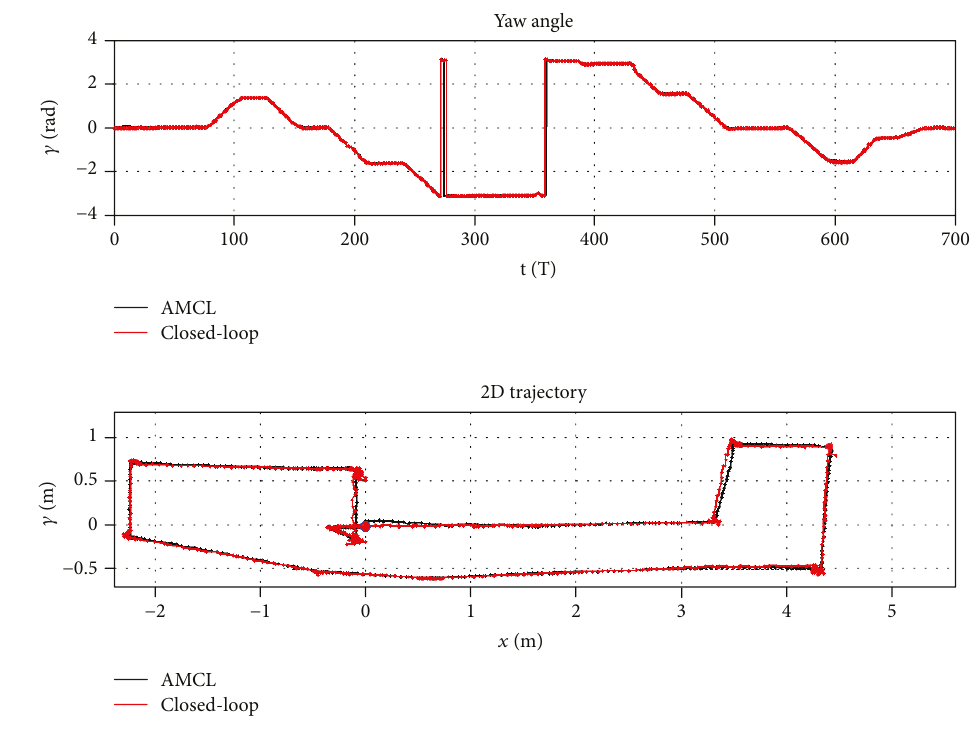
Figure 12: Result of closed-loop motion experiment (closed-loop